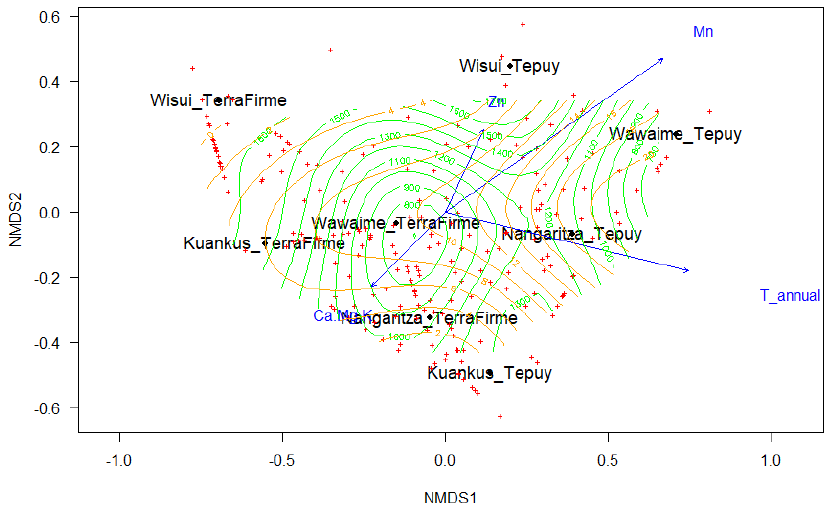
Figure 2. The non-metric multidimensional scaling analysis (NMDS) analysis shows the differentiation between the Terra Firme and Tepuy plots, the green surface represents the elevation, and the orange SO4.